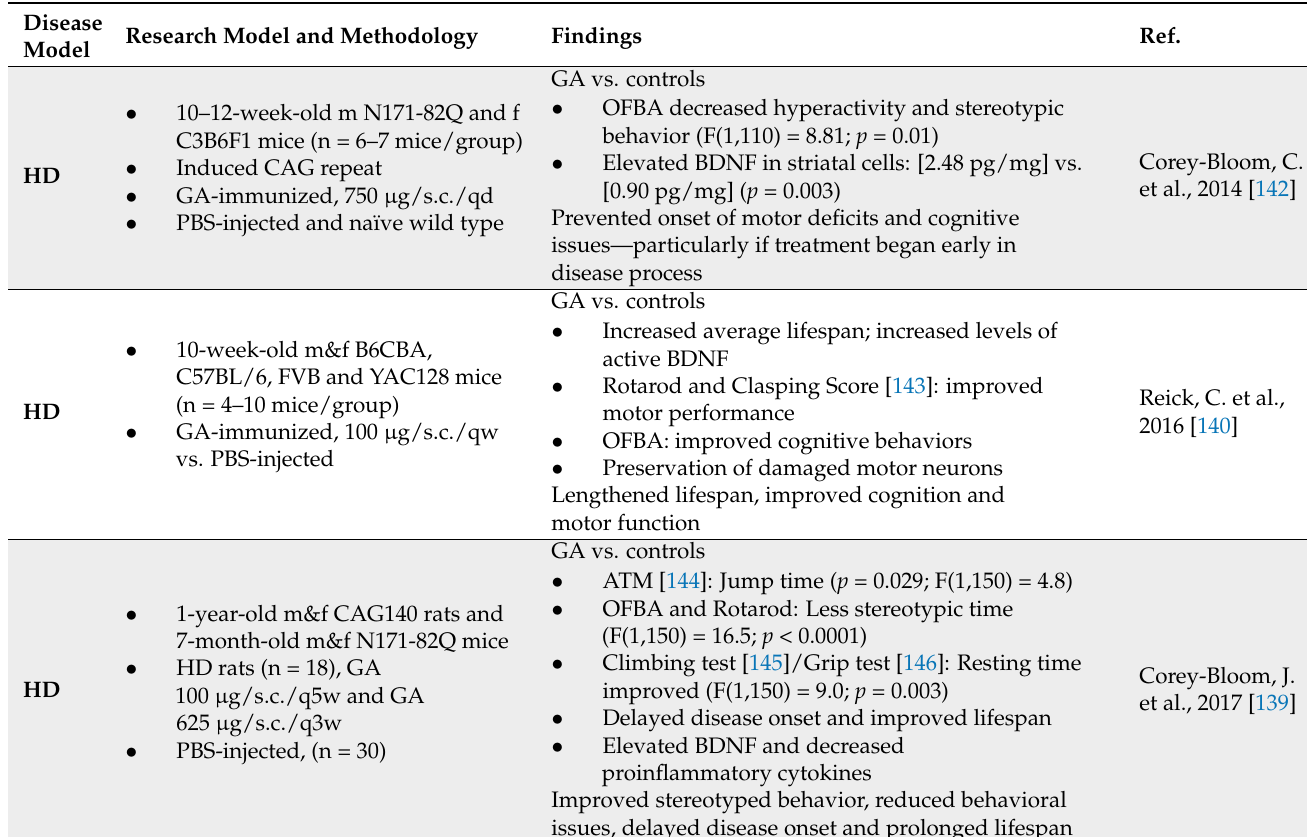
Table 8. Animal Studies Examining Alternative Uses of Glatiramer Acetate in Huntington’s